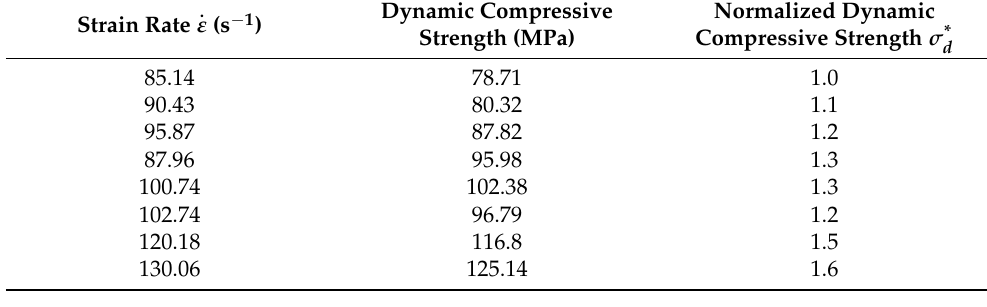
Table 6. Dynamic compressive strengths of sandstone under different strain rates.